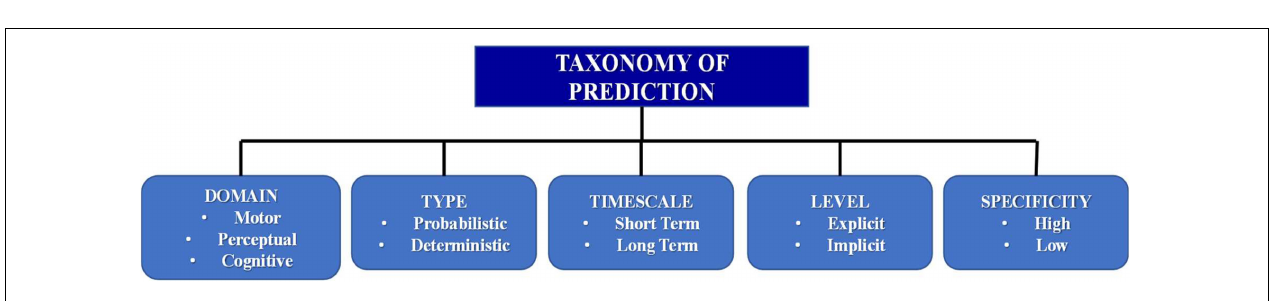
FIGURE 4 | Factors influencing the nature of prediction derived from Bubic et al.